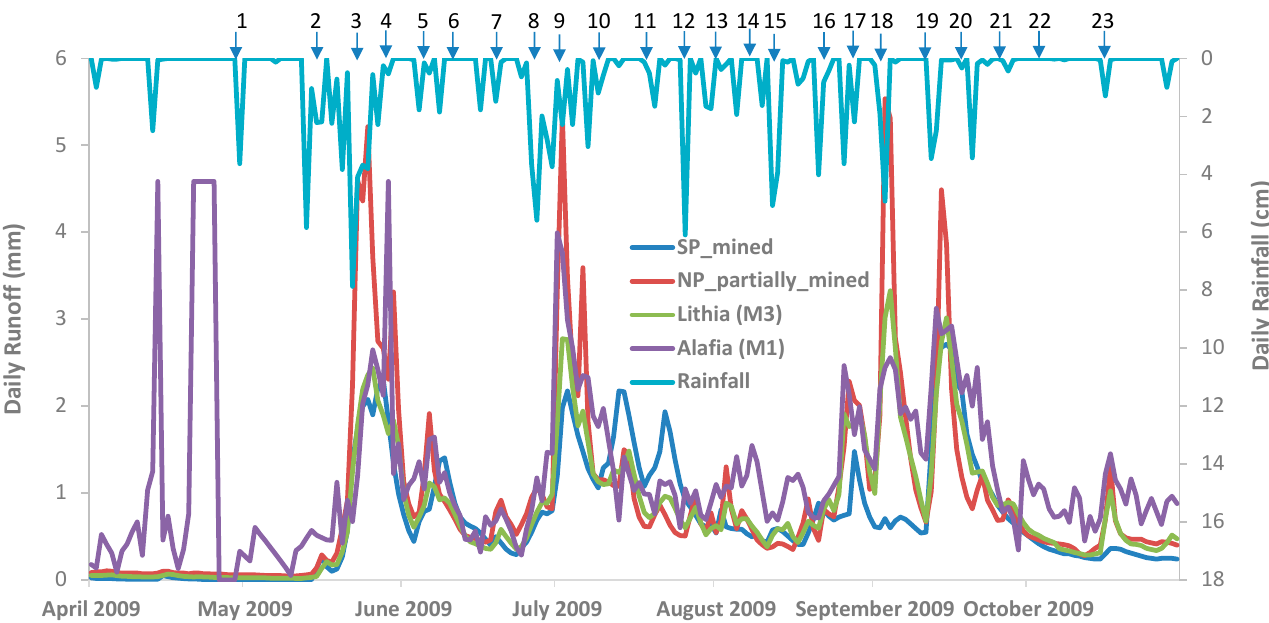
Figure 2. Daily rainfall and daily stream runoff for selected tributaries of the Alafia Watershed from April to October 2009. SP and NP are abbreviated for South Prong and North Prong, respectively. The labels from 1 to 23 on top of the figure indicate the timing of the 23 sampling events.